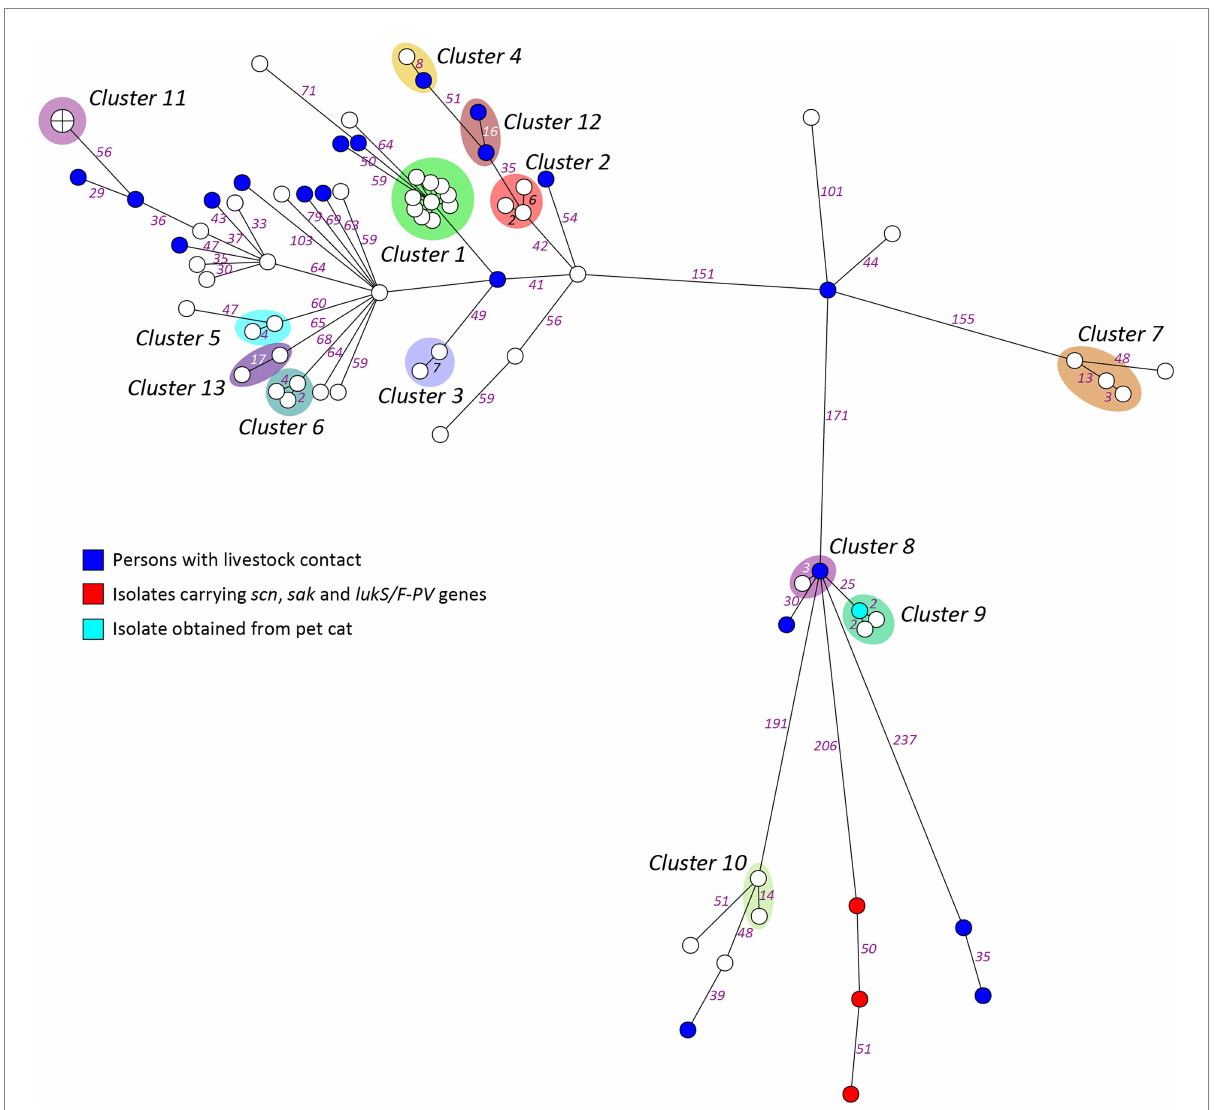
FIGURE 2 Minimum spanning tree based on wgMLST of the study isolates. Genetic distance is represented by the numbers on the connecting lines as the number of allelic differences in the wgMLST